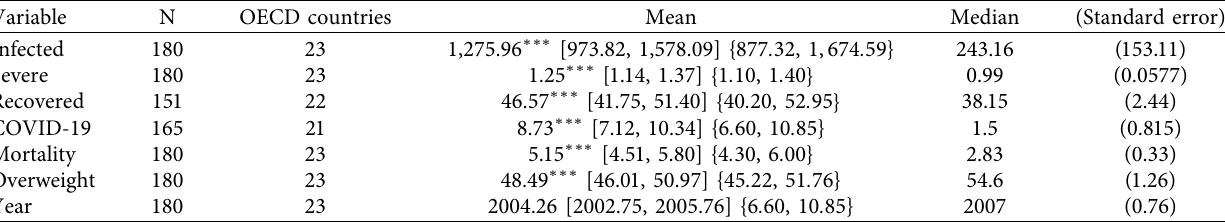
Table 3: Descriptive statistics–pooled